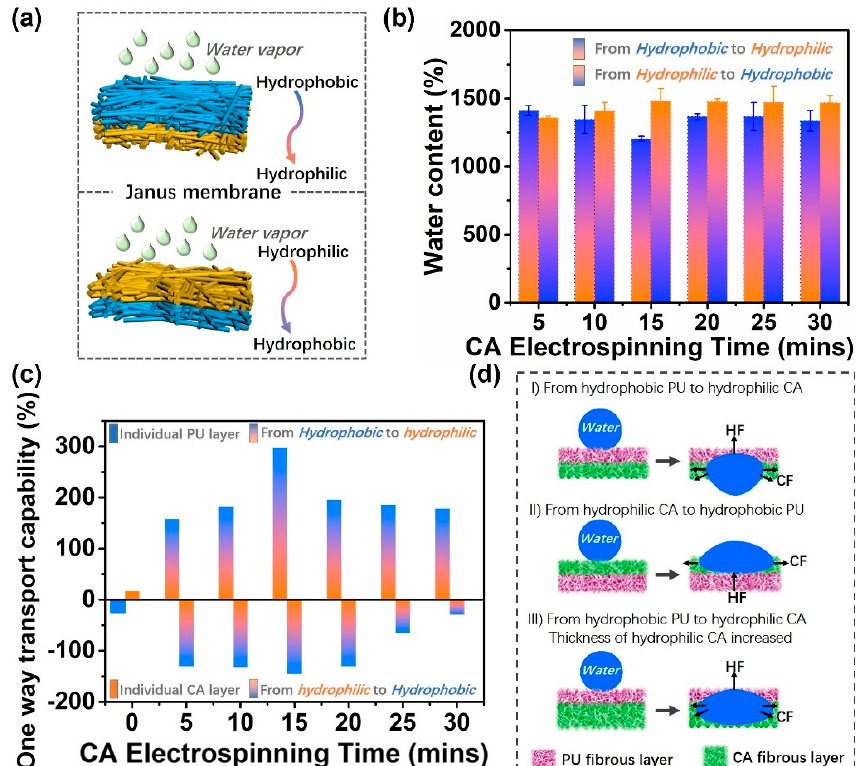
Figure 6. ( a ) Schematic illustration of water vapor transmission. ( b ) Moisture-management testing (MMT) results of hydrophobic PU/hydrophilic CA Janus fibrous membrane with different hydrophilic CA-8G electrospinning times. The water contents tested from the hydrophobic side to hydrophilic side and the reverse direction were taken into consideration. ( c ) The measurements of the one way transport capacity of all as-prepared Janus fibrous membranes. ( d ) The mechanism of the enhanced water vapor transmission.